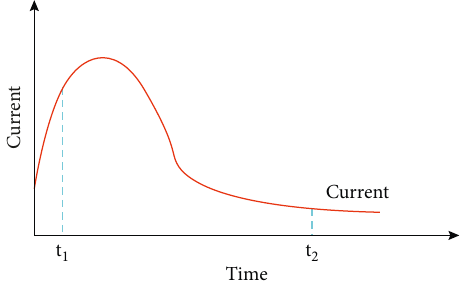
Figure 13: Varying current method